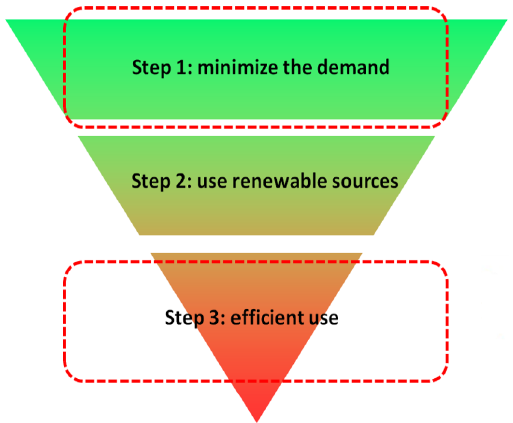
Fig. 1. – Trias Energetica and efficiency